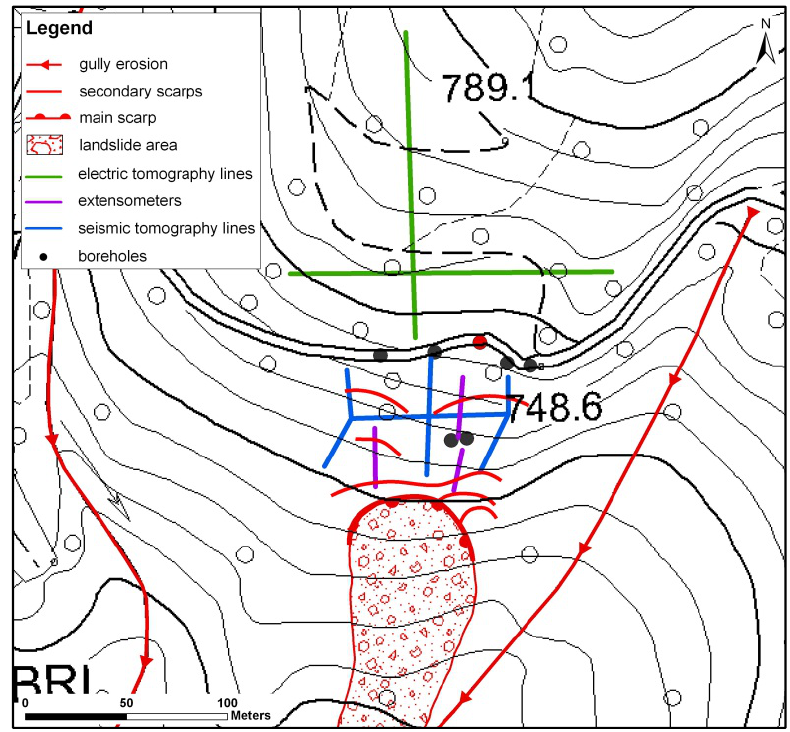
Fig. 6. Location of geognostic and geophysical investigations together with the main geomorphological elements of landslide area. The red solid circle indicates the borehole from which samples for laboratory tests have been collected (see Fig. 8).